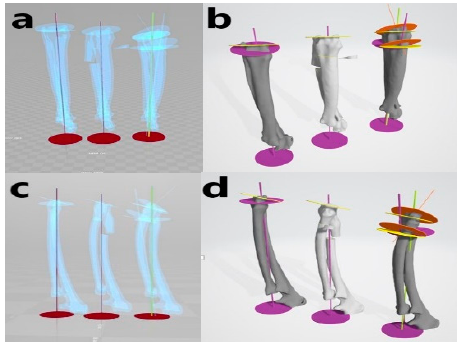
Figure 5. Virtual simulative corrective osteotomy. Surgical simulations were performed in virtual reality to predict postoperative conditions. Note the change in the axis before and after the virtual corrective osteotomy. The figure on the left ( a , c ) shows penetrated images and on the right ( b , d ) are 3 ‐ D rendering images.